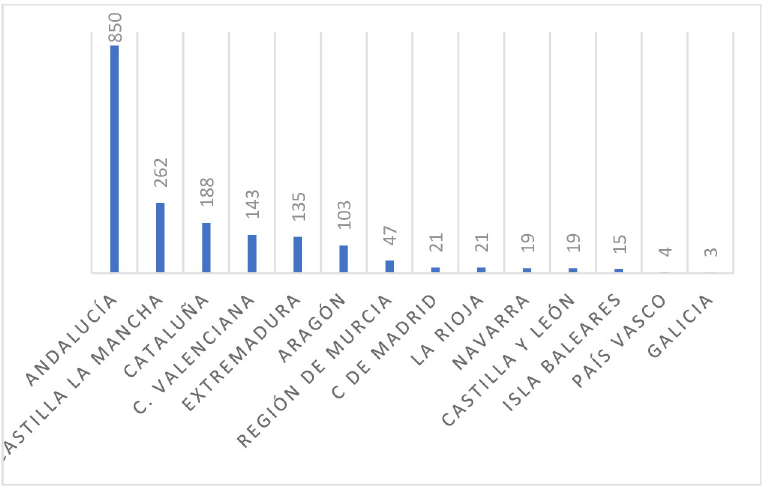
Fig 3. Number of oil mills by autonomous community in Spain (year 2021). Source: Prepared by the authors based on information from the Ministry of Agriculture, Fisheries and Food (MAPA).